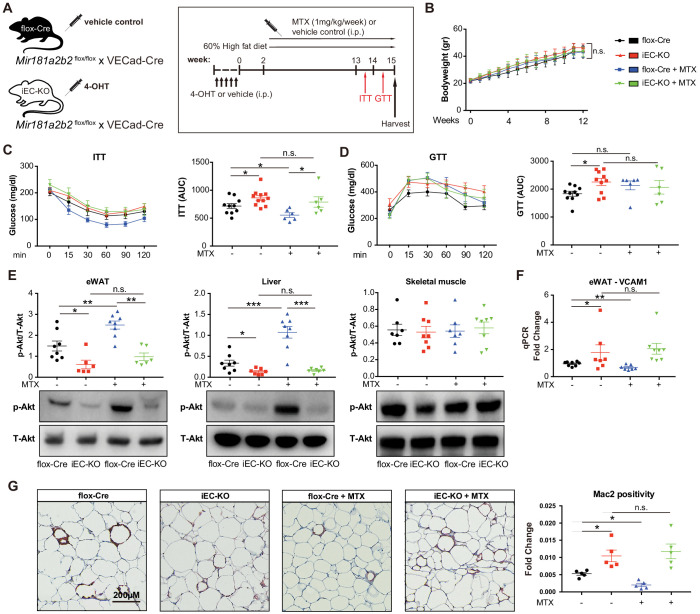
Endothelial cell (EC)-specific Mir181a2b2 KO blocks methotrexate (MTX)-mediated insulin sensitivity and visceral fat inflammation in diet-induced obesity.(A) Schema of experimental procedure for control Mir181a2b2flox/flox; VECad-Cre (flox-Cre) or tamoxifen injected EC-specific Mir181a2b2 KO (iEC-KO) mice that were placed on a 60% high-fat diet (HFD) for 15 weeks. Each group of mice was weekly i.p. injected with vehicle control or MTX (1 mg/kg). (B) Body weights over time of mice treated with vehicle or MTX, respectively. (C–D) ITT (C) and GTT (D) were measured and AUCs were quantified for each group. (E) Western blot analysis of Akt and pSer473-Akt in eWAT, liver, and skeletal muscle tissues. (F) Real-time qPCR analysis of VCAM-1 expression in eWAT. (G) Paraffin sections of eWAT were stained with Mac2 and the positive areas were quantified, n = 5 mice per group, one-way ANOVA. (B–G), n = 6 to 10 mice per group, one-way ANOVA. *p<0.05; **p<0.01; ***p<0.001. All values represent mean ± SEM.